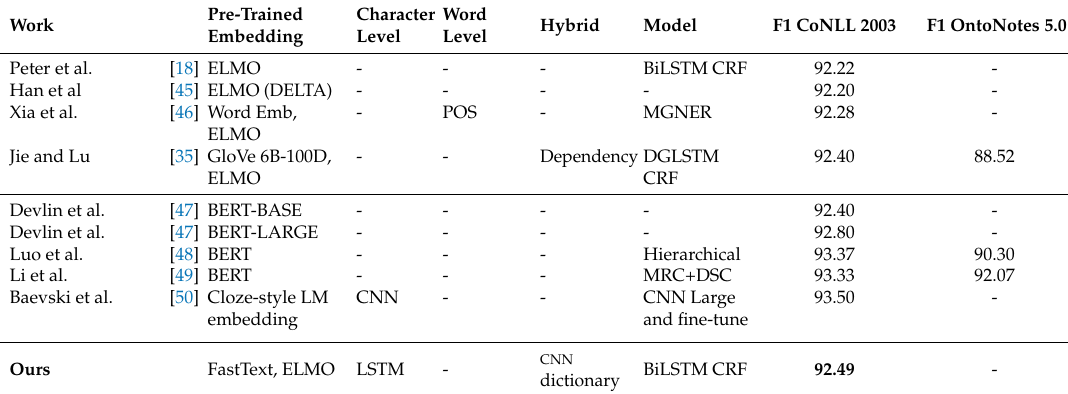
Table 10. The comparison of our model with the previous works having contextual embeddings (ELMO and BERT) as their